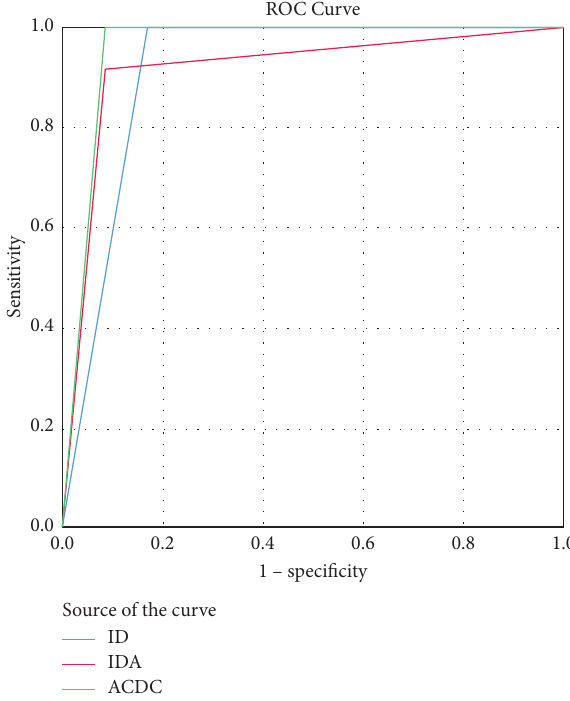
Figure 1: Comparison of ROC curve for IDA, ID, and ACDC in hypothyroid